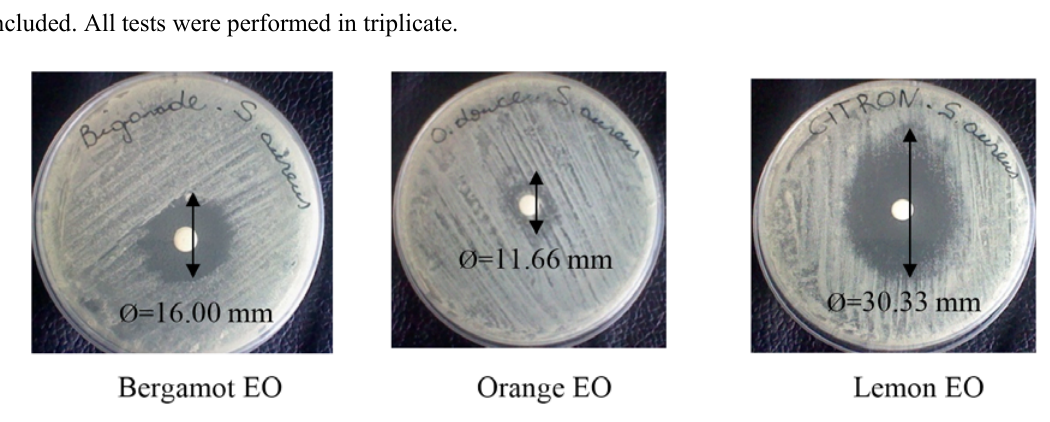
Figure 5. Antibacterial activity ( S . aureus ) of the EOs from citrus, using paper disc-diffusion method, expressed by diameter (mm) of inhibition zone (including the disc diameter, 6